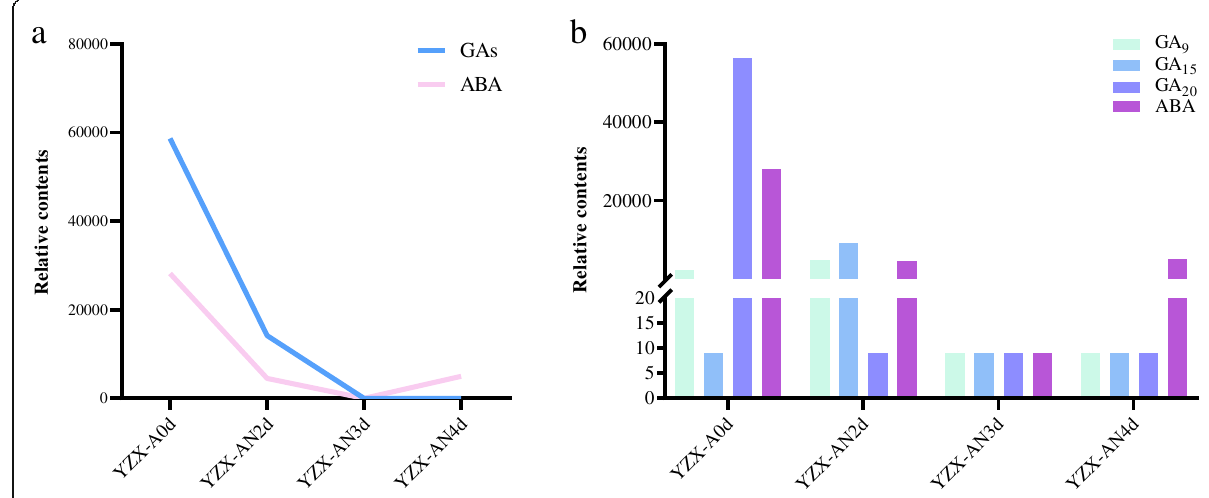
Fig. 10 a The relative content of gas and ABA in YZX seeds at different submerging time points. b The relative contents of three kinds of GA: GA 9 /GA 15 /GA 20 and ABA under the condition of anaerobic germination. AN is for anaerobic